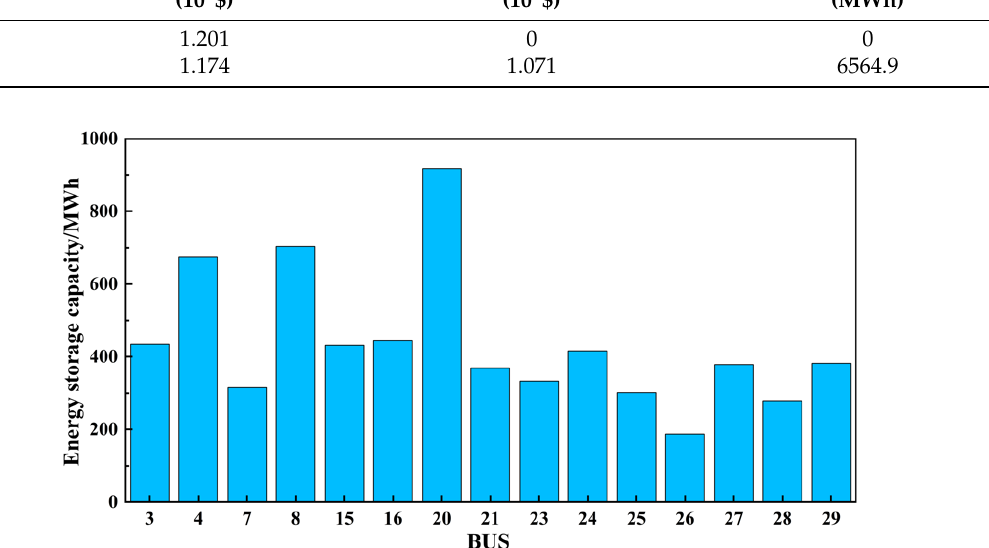
Figure 8. EES capacity configuration after the EES configuration.